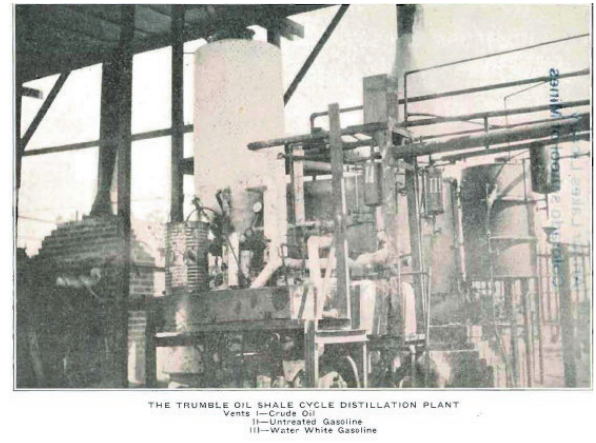
Figure 2. Continuous Distillation Trumble Process. Reproduced from V. Alderson, Quarterly of the Colorado School of Mines 1924 , 19 (3),